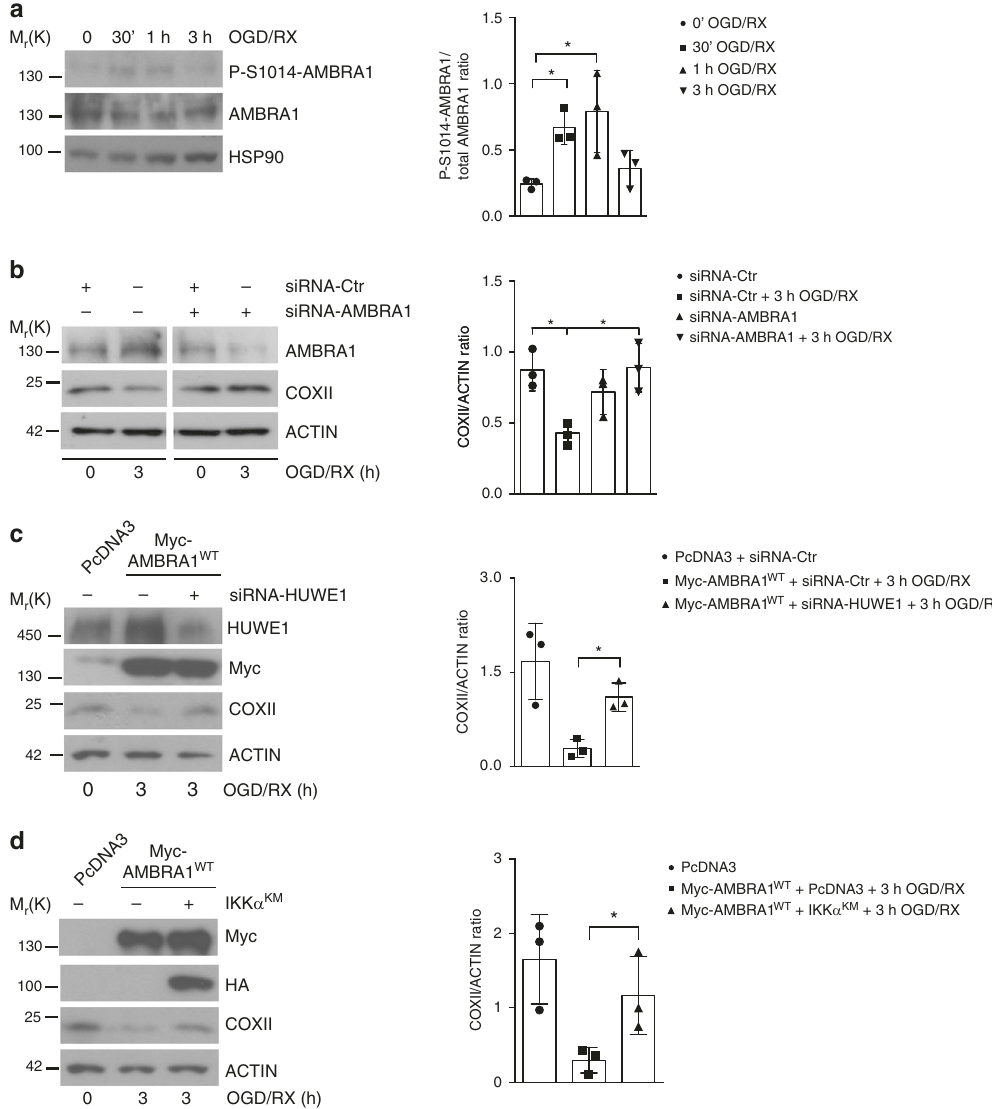
Fig. 7 AMBRA1 induce mitophagy in an in vitro model of ischaemia. a Lysates of SH-SY5Y cells exposed to different time points of OGD/RX (0 min, 30 min, 1 h and 3 h) were blotted with the indicated antibodies; n = 3. b Endogenous AMBRA1 levels were downregulated using siRNA-AMBRA1 in SH- SY5Y cells. Following exposure to 3 h OGD/RX, total lysates were subjected to western blot analysis in order to analyse mitochondria clearance, looking at COXII protein levels; n = 3. c PcDNA3 or Myc-AMBRA1 WT -expressing SH-SY5Y cells were transfected with siRNA-Ctr or siRNA-HUWE1 constructs and then immunoblotted for the indicated proteins; n = 3. d SH-SY5Y cells transfected with PcDNA3 or HA-IKK α K44M constructs in combination with Myc- AMBRA1 WT were subjected to western blot analysis for the indicated antibodies; n = 3. Data represent the mean of three different experiments (±S.D.). * P < 0.05. Statistical analysis was performed using one-way ANOVA. M r (K) = relative molecular mass expressed in